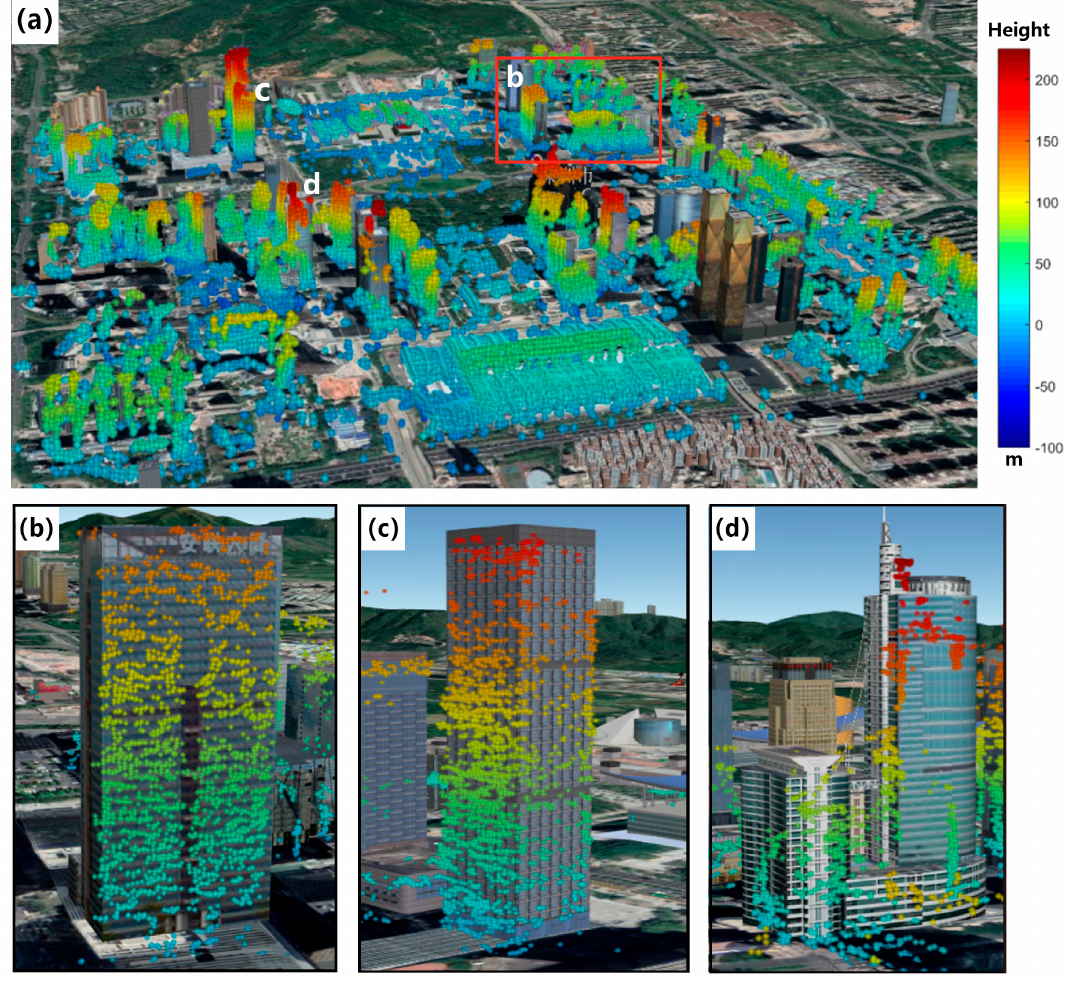
Figure 6. Three-dimensional visualization results of the PS height. ( a ) The panoramic view of PS height in the study area and ( b – d ) the local magnification of buildings ( b ), ( c ), and ( d ), respectively. The red rectangle represents the FengHuang building.